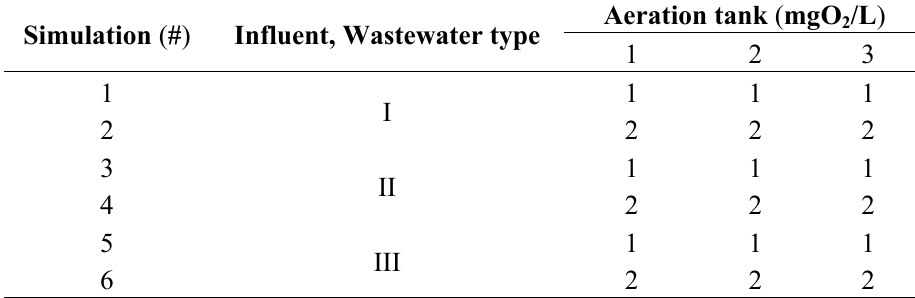
Table 2. Summary of the performed wastewater treatment (WWT)